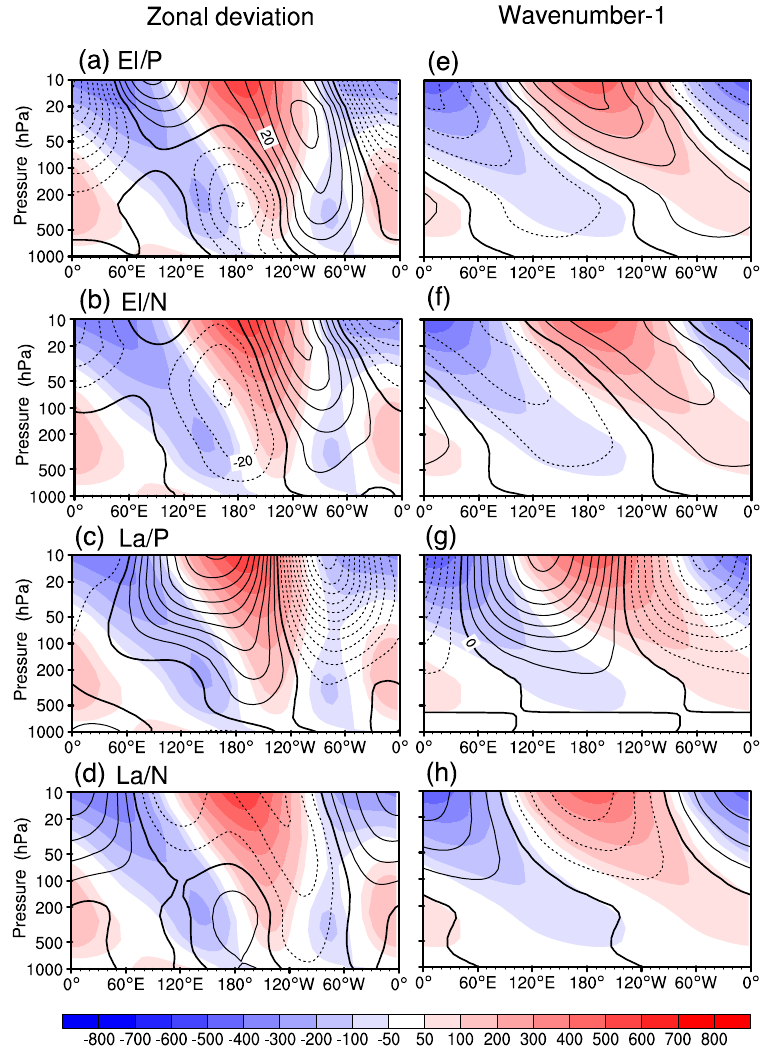
Figure 5. Pressure–longitude cross-sections of composite eddy height anomalies averaged in the 45–75° N latitude band during El Niño winters when the PDO is in its ( a ) positive and ( b ) negative phases and those during La Niña winters when the PDO is in its ( c ) positive and ( d ) negative phases (contours; units: gpm; interval: 10). ( e – h ) As in ( a – d ) but for the zonal wavenumber-1 components. Shadings are the corresponding eddy height climatology (units: gpm) in the 45–75° N latitude band.